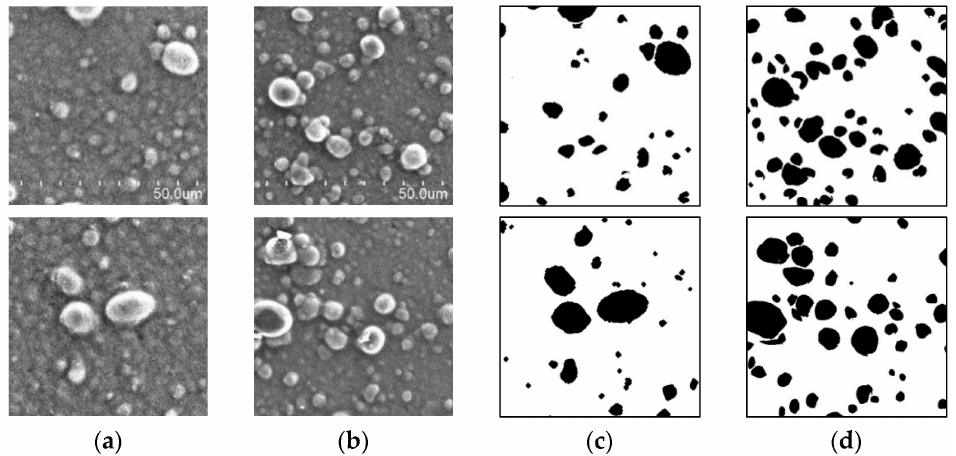
Figure 1. Sample dataset. Input data for a ( a ) small and ( b ) large number of particles. Output data for a ( c ) small and ( d ) large number of particles.